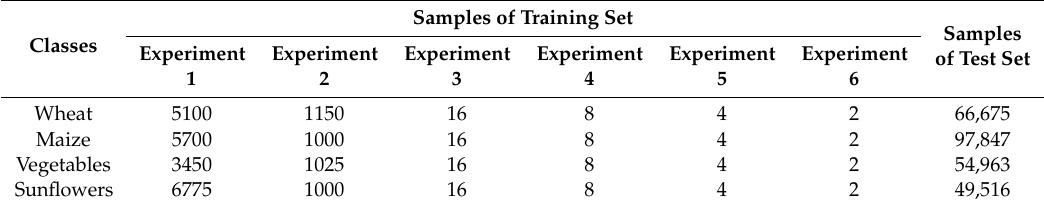
Table 3. Labeled samples of the training set and test set for a small-scale area in Hetao Irrigation District, at the upper reaches of the Yellow River